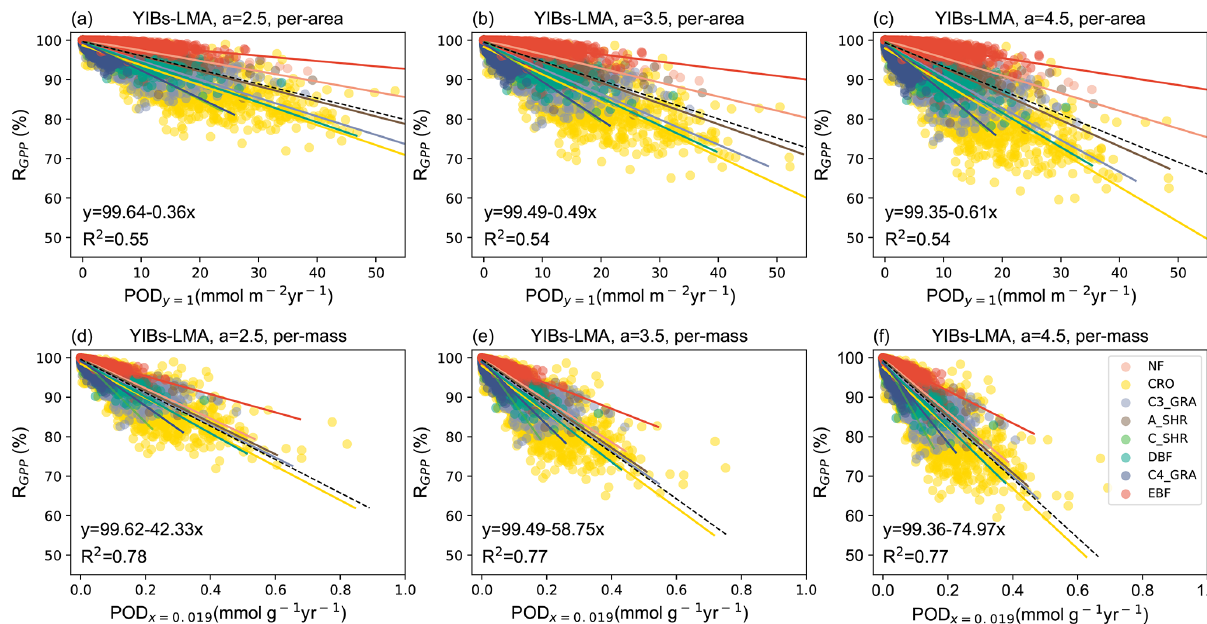
Figure 2. Simulated area-based (a, b, c) or mass-based (d, e, f) DRRs for the YIBs-LMA experiment. Three tests from the YIBs-LMA experiment all adopt x = 0 . 019nmolg − 1 s − 1 and gridded LMA from M2018 with parameter a = 2 . 5, 3.5, and 4.5nmol − 1 sg, respectively. Each dot represents estimated POD- R GPP (POD y = 1 for a – c , POD x = 0 . 019 for d – e ) at a grid with corresponding PFT. The PFT-specific regressions between area- or mass-based POD and R GPP are displayed with solid lines shown in legend. Regression relationships of all PFTs are displayed by the dashed black line, with coefficients of determination ( R 2 ) denoted in each panel. Note the differences of ranges in x axis among PFTs. The YIBs-LMA experiment is summarized in Table